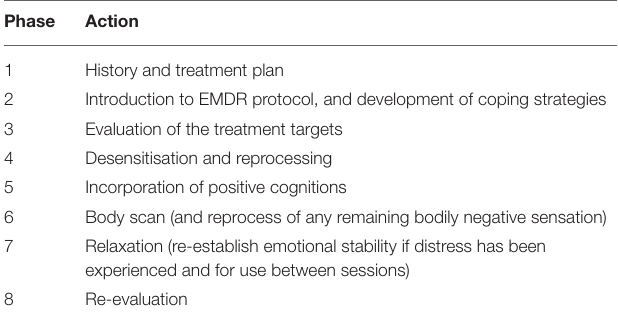
TABLE 1 | Eight-phase protocol of EMDR according to Shapiro (1989, 2001,